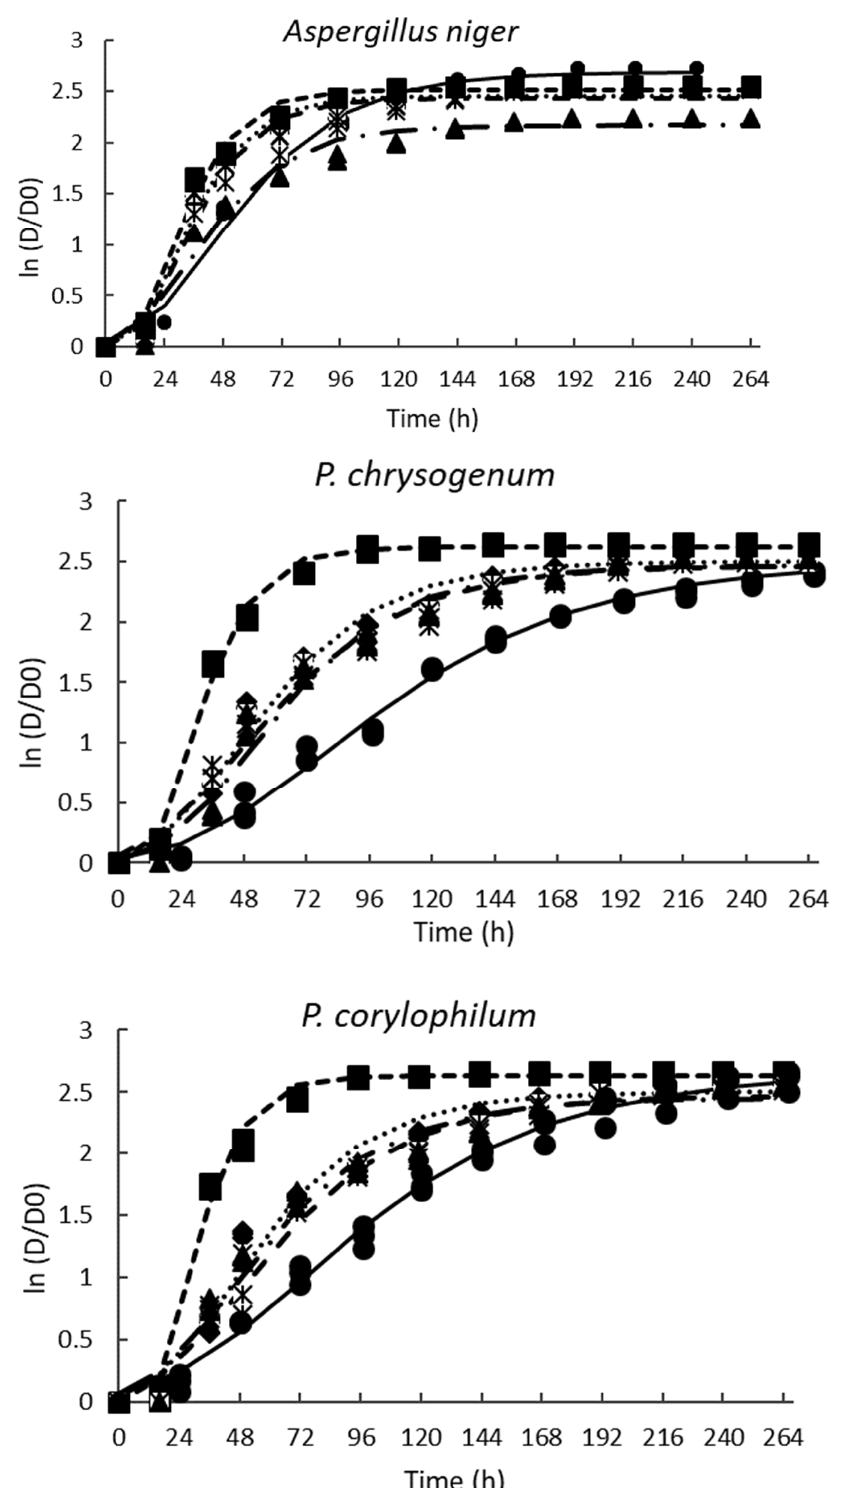
Figure 4. Effect of the different concentrations of pasteurized aqueous extracts (AE) from poolish- type sourdough fermented with Lactiplantibacillus plantarum NRRL B-4496 for 48 h on the growth of the tested molds. Potato-dextrose agar (PDA) control ( ◾ ), PDA + 20% AE ( ), PDA + 26% AE (*), PDA + 33% AE ( ▲ ), PDA + 50% AE (•), and lines are the predicted values using the modified Gompertz equation.